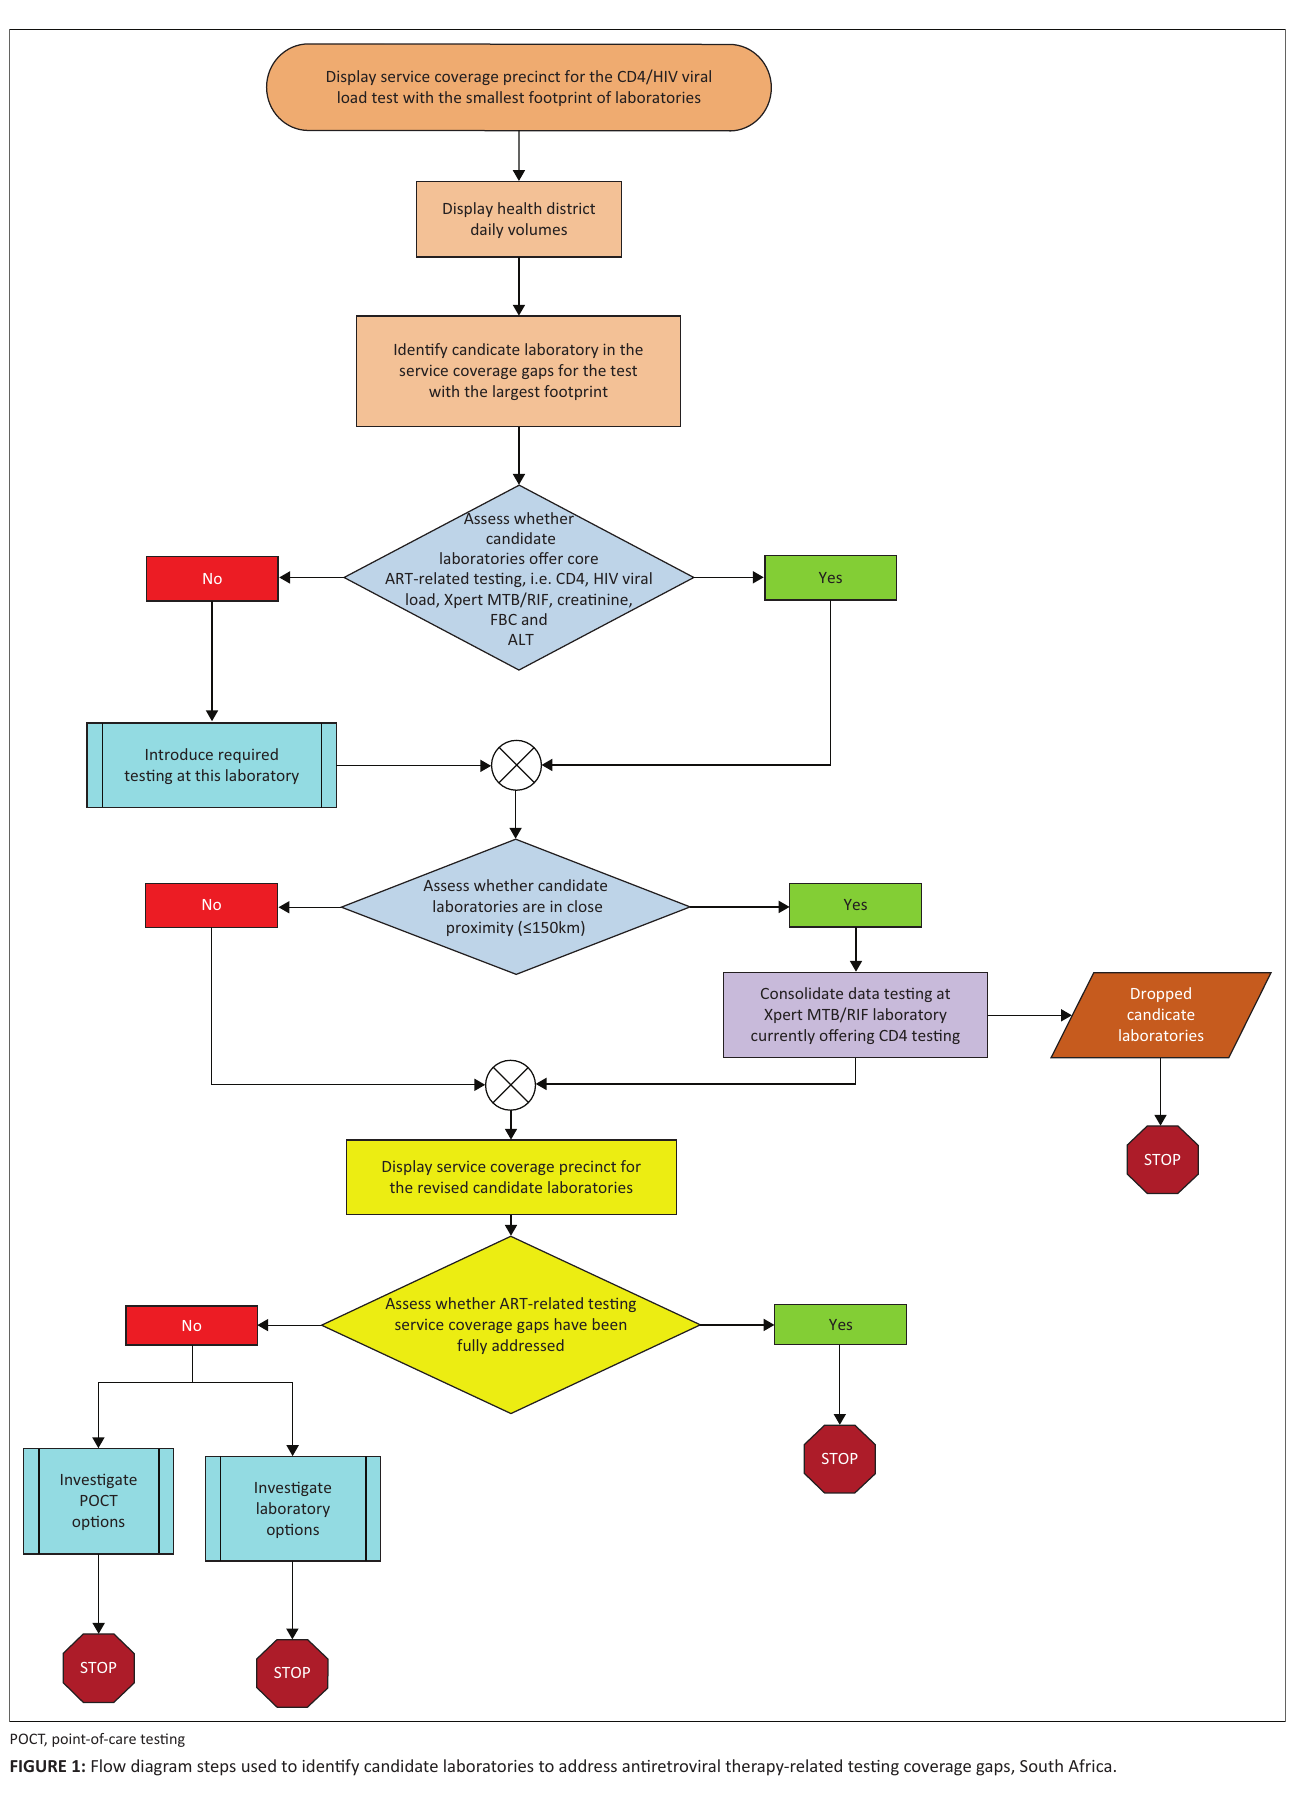
FIGURE 1: Flow diagram steps used to identify candidate laboratories to address antiretroviral therapy-related testing coverage gaps, South